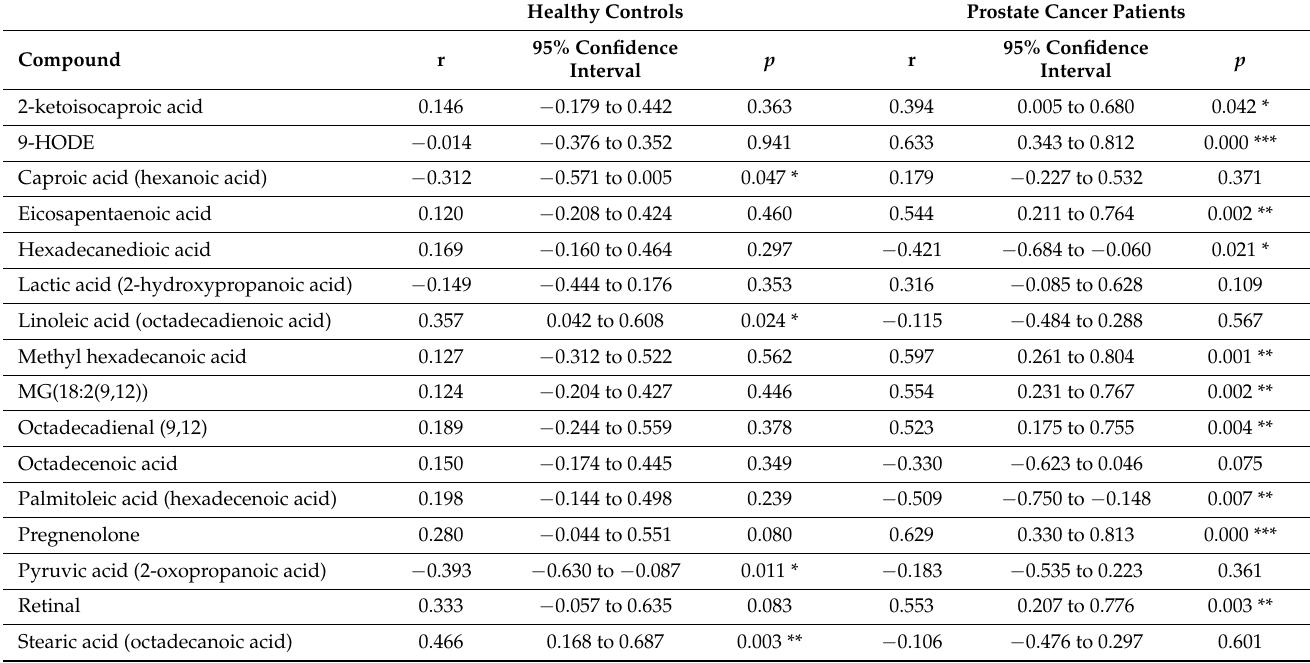
Table 3. Correlation between altered metabolites and levels of plasma 4-HNE-protein adducts. Healthy Controls Prostate Cancer